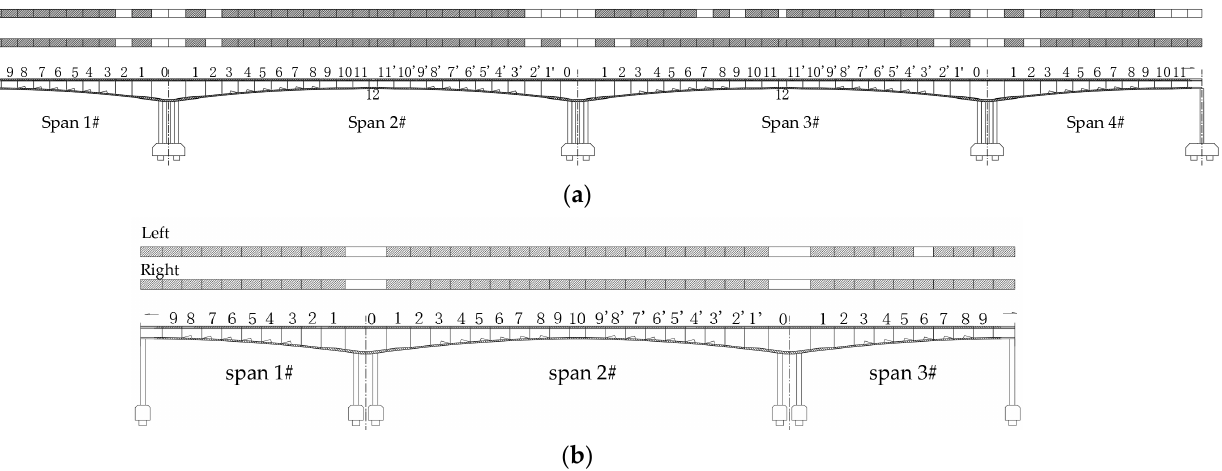
Figure 7. Cross-section inspection status. (The gray block represents the checked section. The number on the beam represents the segment number. The span ( ∙ )# is the span number). ( a ) Bridge A, ( b ) Bridge B.